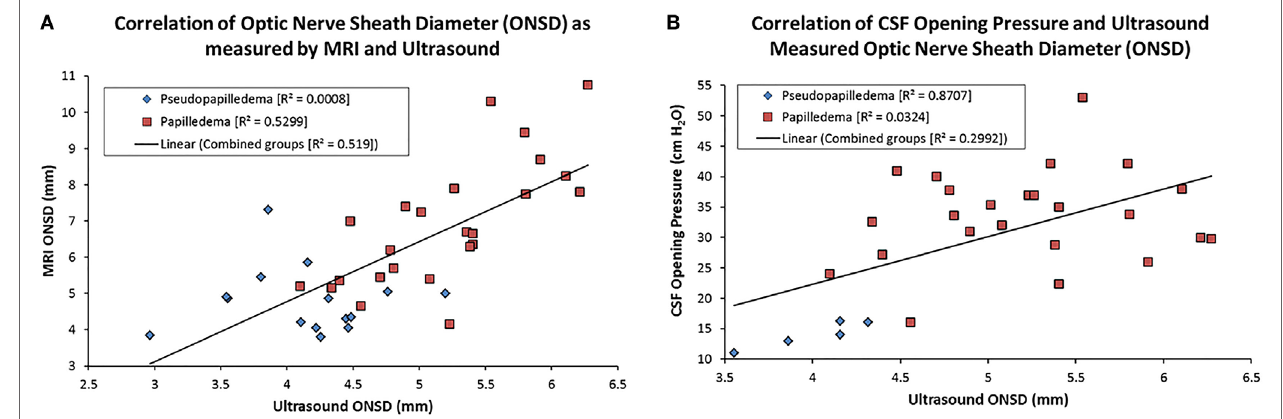
FigUre 2 | Scatter plots showing the correlation between magnetic resonance imaging (MRI)- and US-measured optic nerve sheath diameter (ONSD) (a) and cerebrospinal fluid (CSF) opening pressure and US ONSD (B) . The linear regression line on each is based on the combination of the papilledema and pseudopapilledema